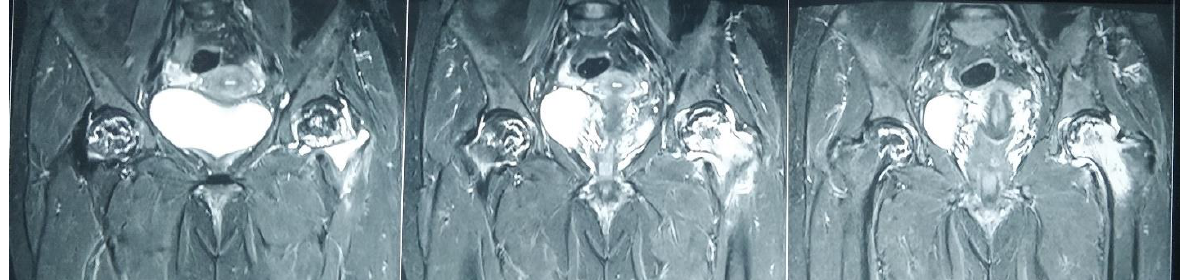
Figure 3: MRI imaging of bilateral hips